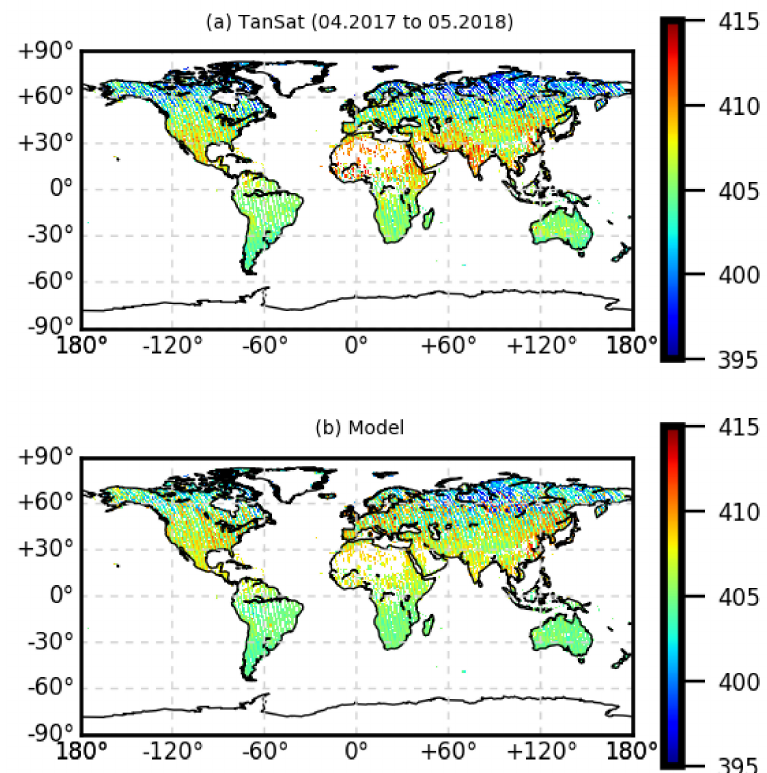
Figure 3. Comparison of the TanSat XCO 2 v2 dataset from IAPCAS ( a ) with the GEOS-Chem model ( b ). The GEOS-Chem model driven by surface fluxes that have been optimised with surface in-situ data. GEOS-Chem model output is sampled according to the location of cloud-free, quality-filtered TanSat retrievals. The colour scale gives XCO 2 in ppm.